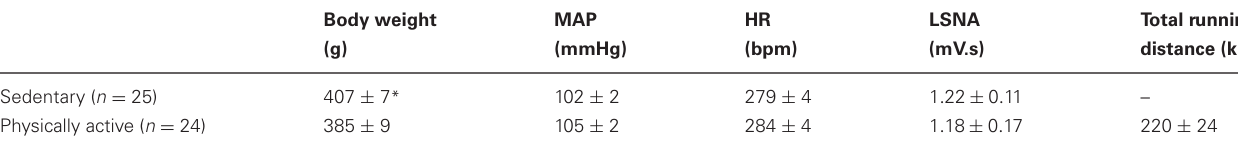
Table 1 | Baseline characteristics of sedentary versus physically active animals.